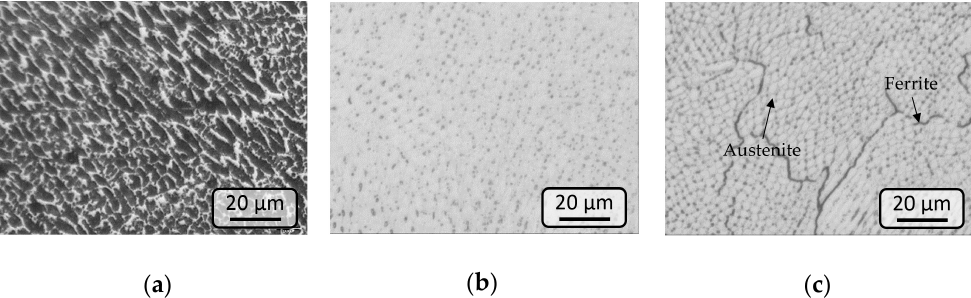
Figure 8. Microstructure details of the FGM sample along the gradient (specific location shown in Figure 6): ( a ) eighth layer, 100% AISI H13 with its microstructure constituted by martensite and austenite, ( b ) sixth layer, 40% AISI 316L and 60% AISI H13 with mostly austenitic microstructure, ( c ) first layer, 100% AISI 316L with austenite and ferrite constituted microstructure.